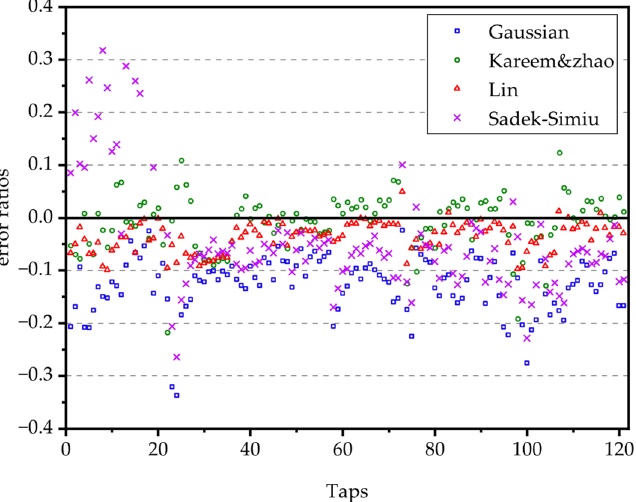
Figure 15. Error ratios of di ff erent peak factor methods. Table 5. Summary of peak factors obtained by di ff erent methods.